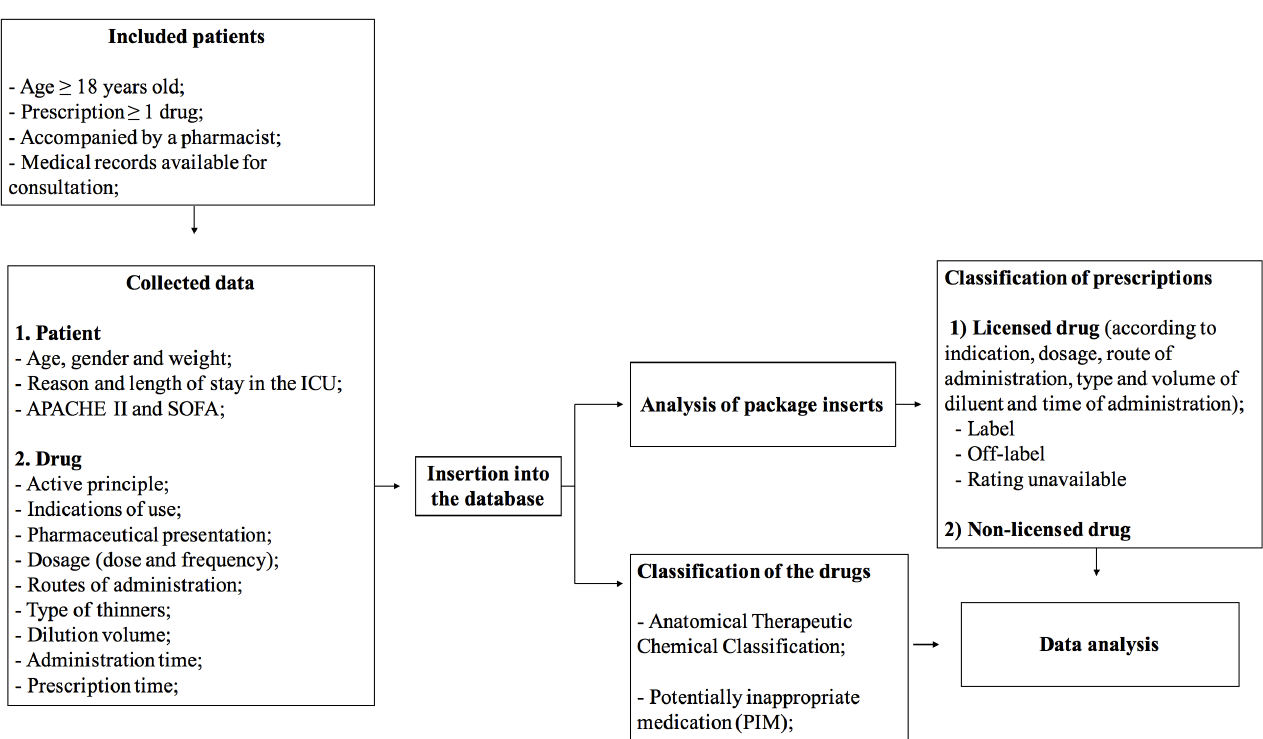
FIGURE 1 - Workflow of the study protocol: Selection and enrollment of patients, drug information with further analysis of package inserts, and drug